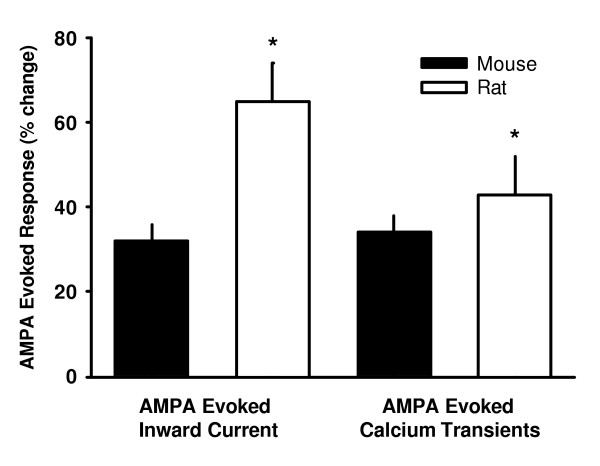
Comparison between AMPA-evoked responses in SCN neurons of rats and mice. Optical imaging techniques were used to estimate Ca2+ responses to A MPA in ventral SCN neurons during the night (ZT 15–17). Application of PACAP increased AMPA-evoked currents and Ca2+ responses in ventral SCN region of mice and rats. The left two histograms compare PACAP (10 nM, 240 sec) enhancement of AMPA (25 μM, 120 sec) induced currents in mouse and rat. The right two histograms compare PACAP (10 nM, 240 sec) enhancement of AMPA (25 μM, 120 sec) induced Ca2+ transients in mouse and rat. Pretreatment with PACAP significantly increased AMPA evoked currents and Ca2+ transients in both mice and rats. In both cases, the effects of PACAP were significantly larger in the rat. Asterisks indicate values that are significantly greater in the rat then in the mouse (P < 0.05). Data is shown as means ± SE.